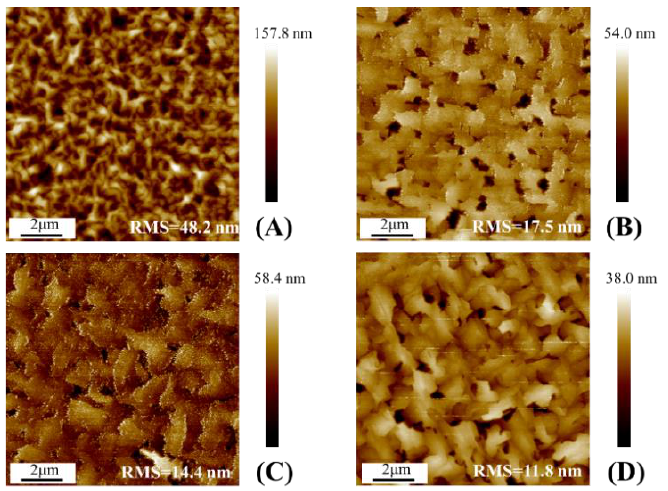
Figure 2. AFM images of the different thickness of InP epilayer grown at 350 °C: ( A ) 10 nm, ( B ) 50 nm, ( C ) 100 nm, and ( D ) 200 nm.